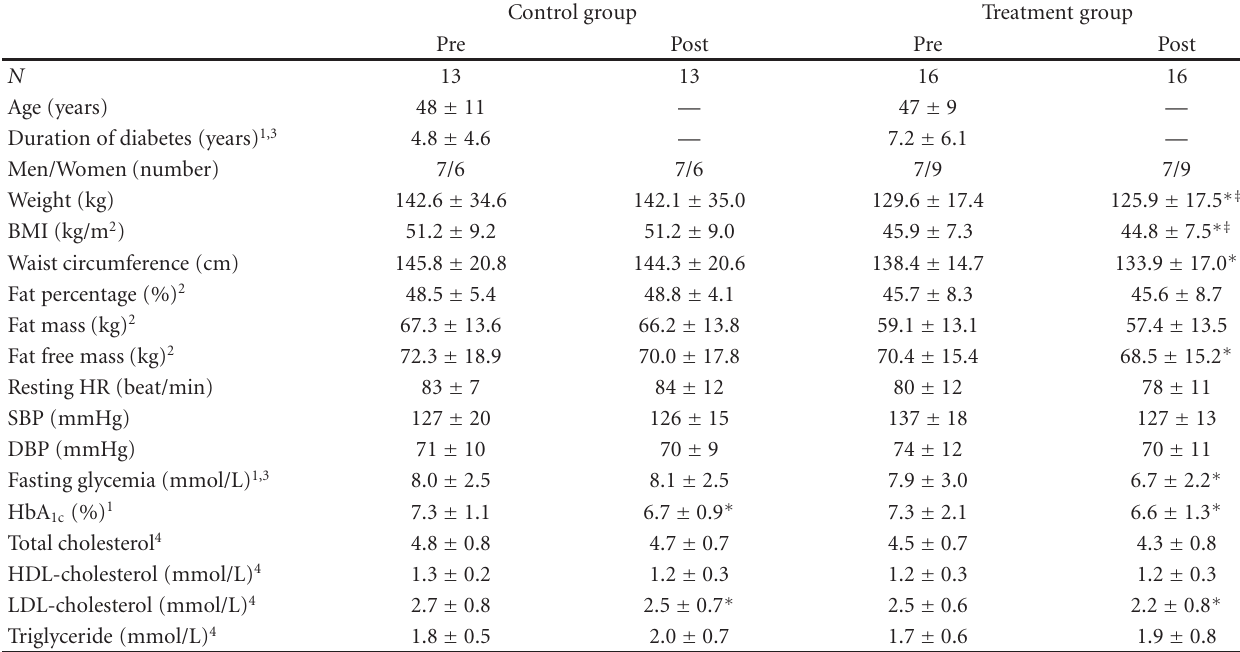
Table 1: Baseline characteristics of type 2 diabetic severely obese subjects before and after